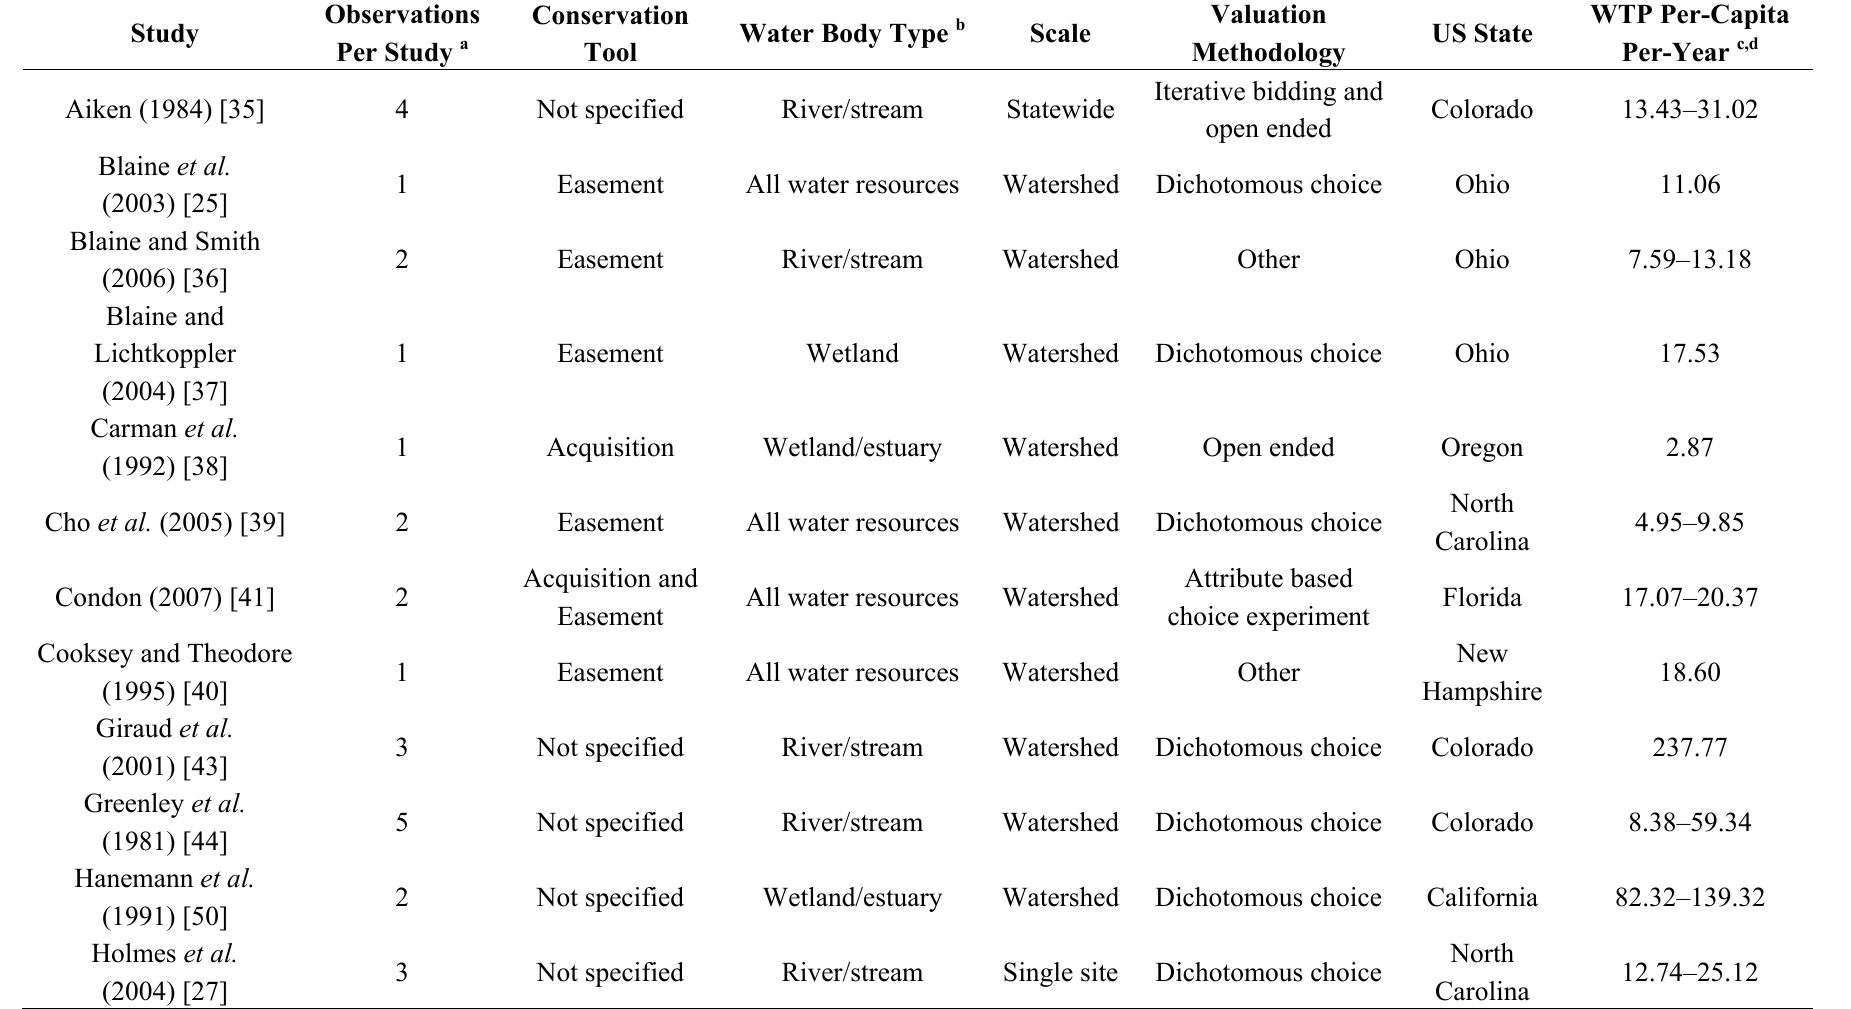
Table 1. Summary of studies estimating willingness-to-pay (WTP) for protection of unimpaired water